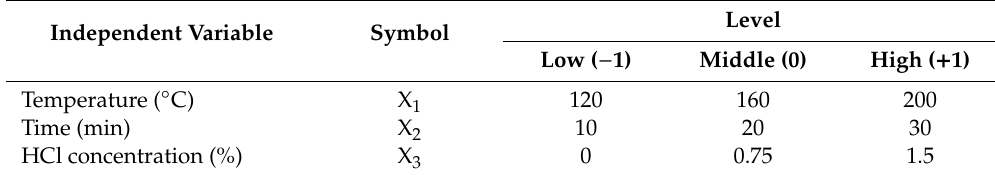
Table 1. Coded and actual levels of independent variables for the designed experiment. Independent Variable Symbol